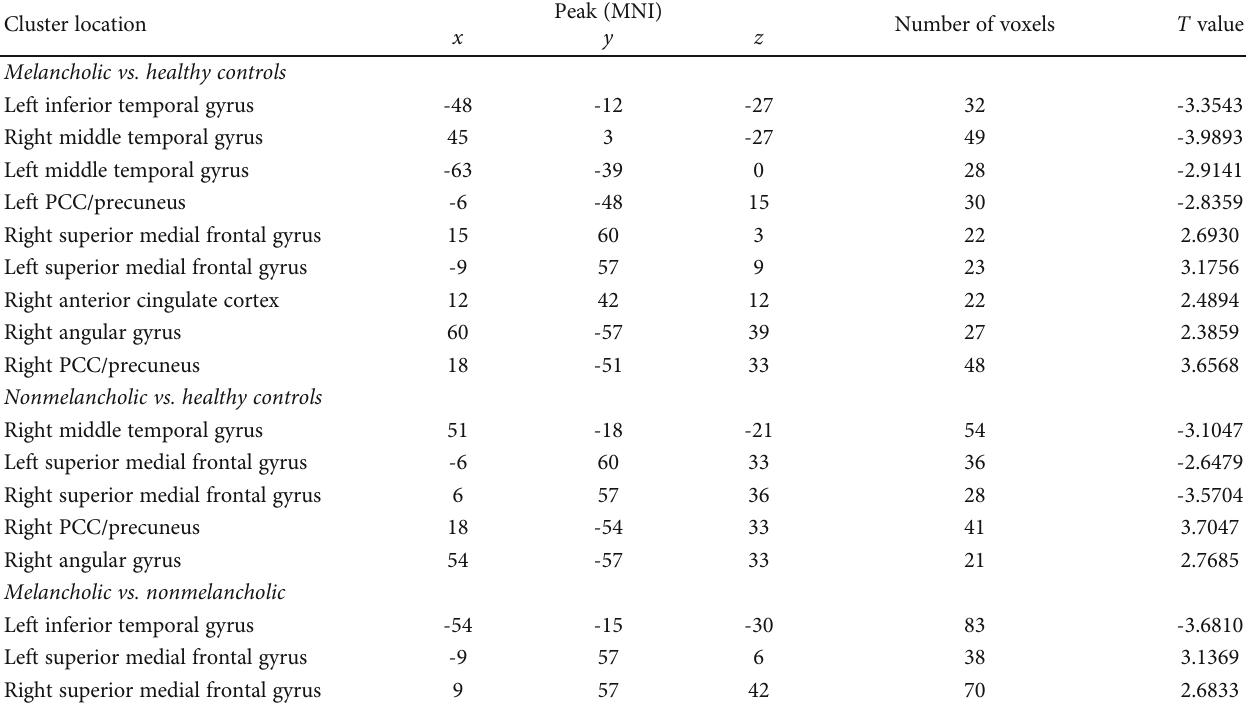
Table 2: Signi fi cant DMN NH di ff erences across